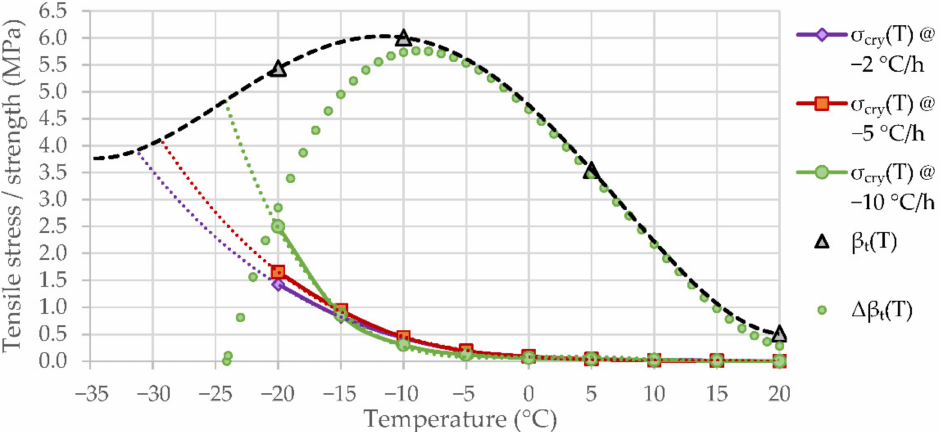
Figure 9. Mean results of the thermal stress restrained specimen test (TSRST) tests for PMB25 mixture at three different cooling